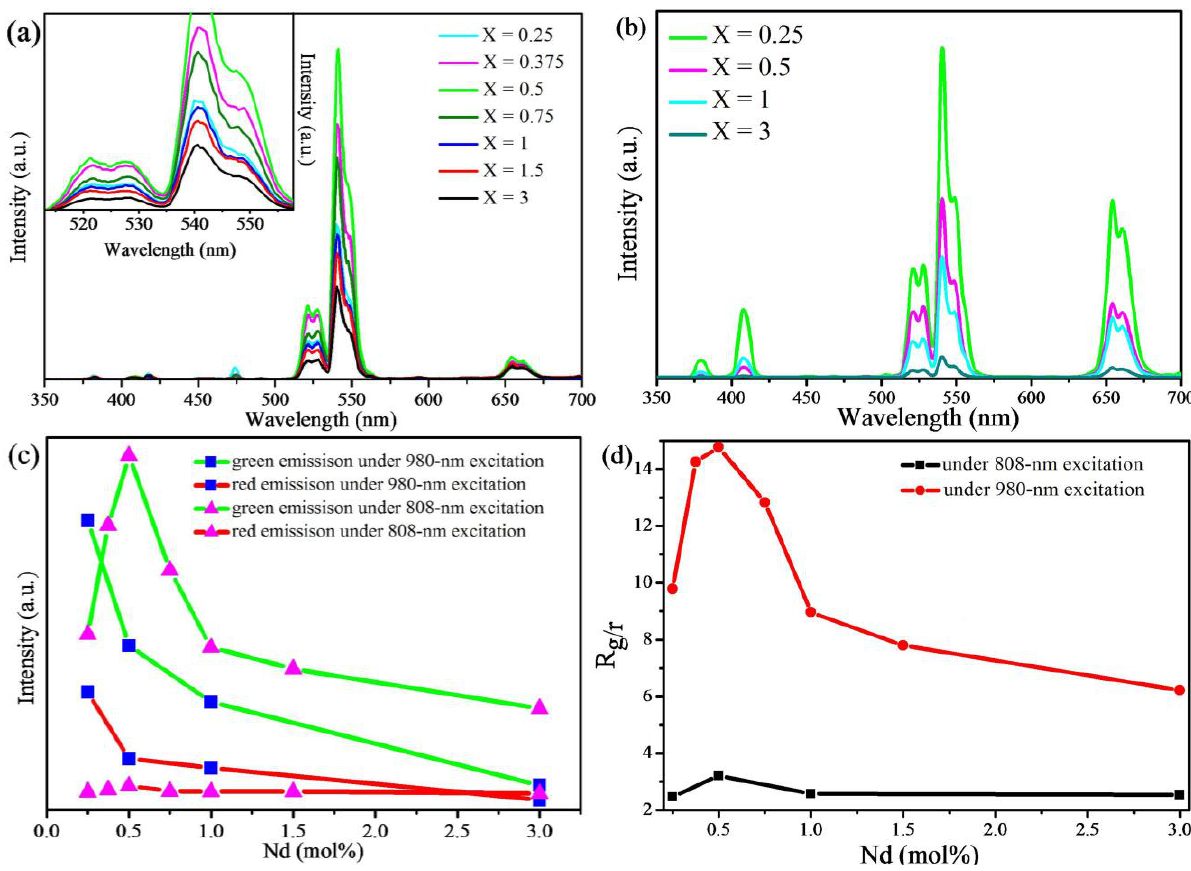
Figure 5. Upconversion emission spectra of the NaYF 4 : Yb/Er/Nd (20/2/ X mol%) nanoparticles under ( a ) 808-nm excitation and ( b ) 980-nm excitation. The inserted image in ( a ) is the magnified green emissions; ( c , d ) the dependence of green and red emission intensity on Nd 3+ concentration and the dependence of R g/r on Nd 3+ concentration of the NaYF 4 : Yb/Er/Nd (20/2/ X mol%) nanoparticles under 808-nm and 980-nm